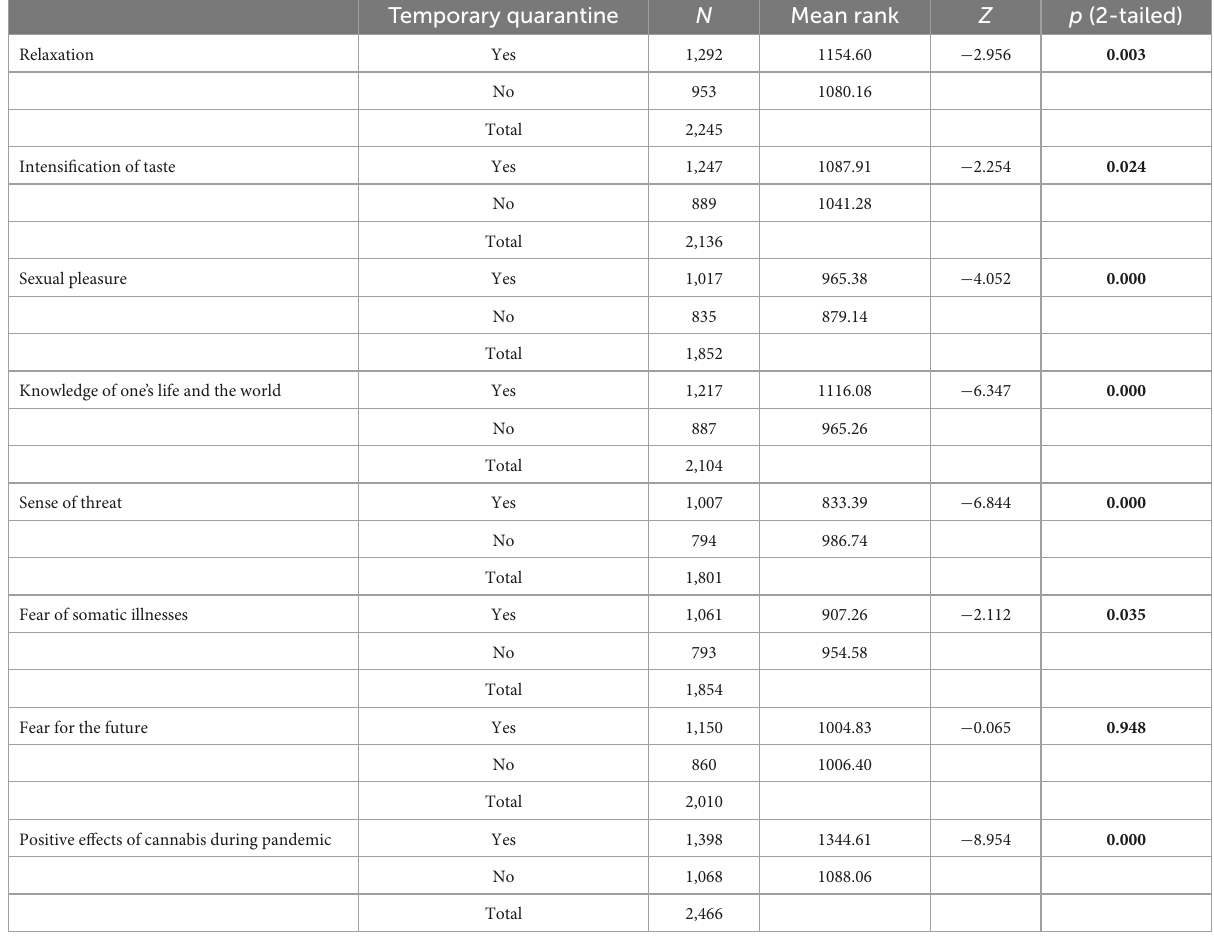
TABLE 4 Impact of quarantine on the experience of cannabis effects, corona-related positive effects of cannabis intake and consumption quantities. Temporary